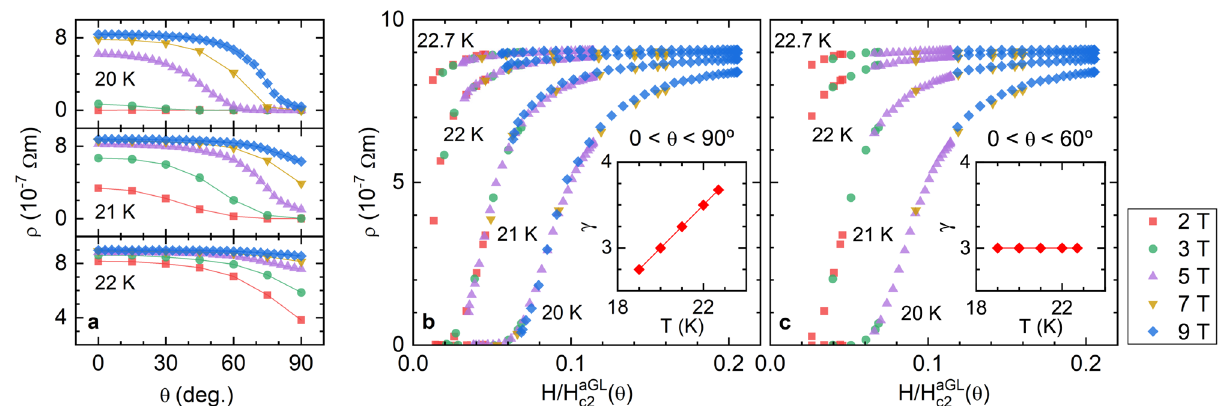
Figure 5. Analysis of the 3D-aGL scaling of the resistivity for different temperatures near T c . ( a ) Some examples of the raw unscaled data. ( b ) Scaling obtained by using a temperature dependent anisotropy factor (shown in the inset). ( c ) Scaling of the data with θ < 60 ◦ (for which H c 2 still follows the 3D-aGL approach). In the latter, an excellent scaling is obtained with a temperature independent γ